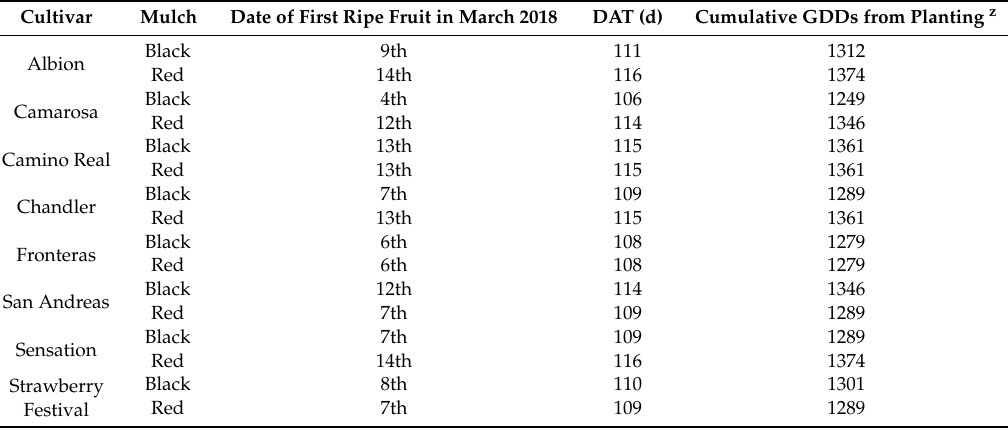
Table 3. Date of first ripe fruit, days after transplanting (DAT), and cumulative growing degree days (GDDs) required for the first ripe fruit from planting of six June-bearing and two day-neutral strawberry cultivars grown with black or red plastic mulches in a high tunnel in Starkville, Mississippi from November 2017 to June 2018. Cultivar Mulch Date of First Ripe Fruit in March 2018 DAT (d) Cumulative GDDs from Planting